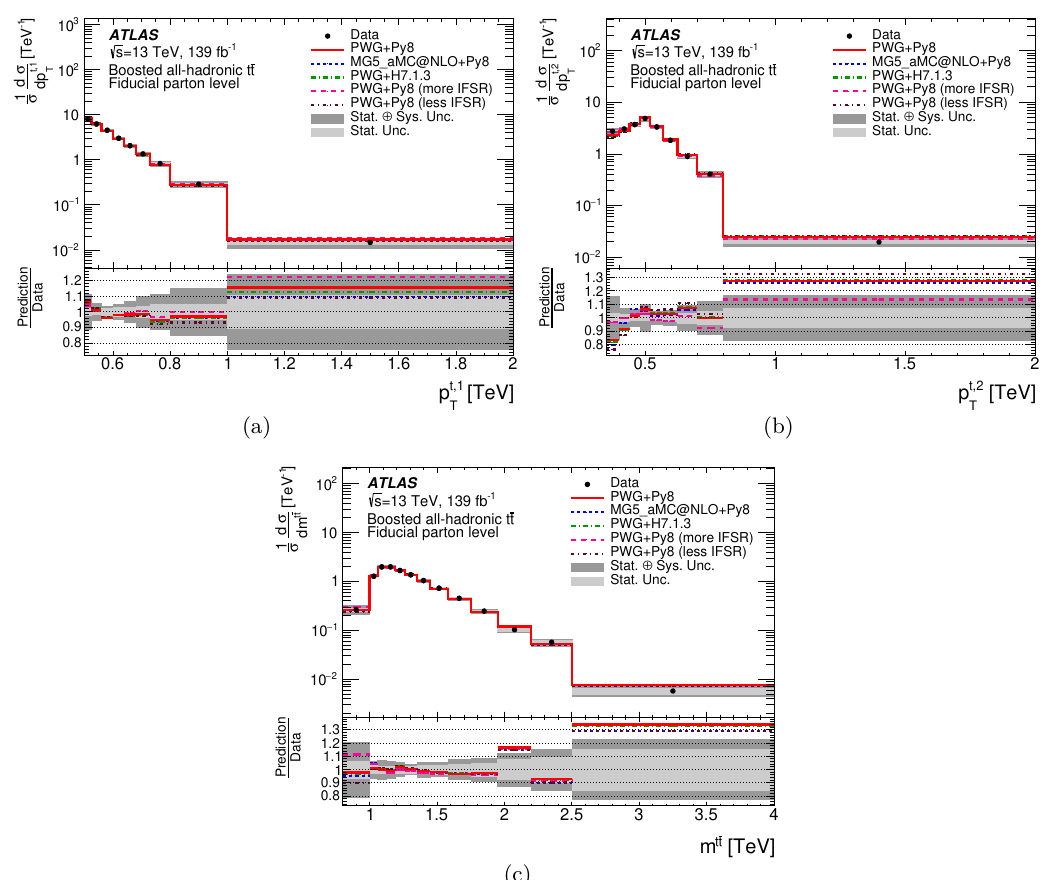
Figure 22 . Normalized parton-level fiducial phase-space differential cross-sections as a function of (a) the p T of the leading top quark, (b) the p T of the second-leading top quark, and (c) the invariant mass of the t ¯ t system. The dark and light grey bands indicate the total uncertainty and the statistical uncertainty, respectively, of the data in each bin. Data points are placed at the centre of each bin. The Powheg+Pythia 8 MC sample is used as the nominal prediction to correct the data to parton